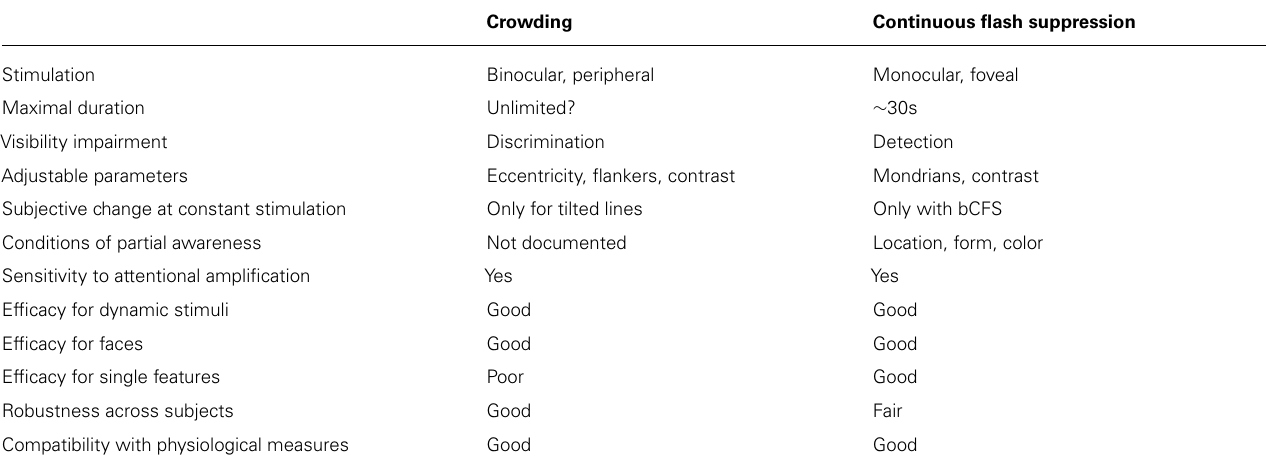
Table 1 | Summary of the comparison of crowding and CFS on different psychophysical